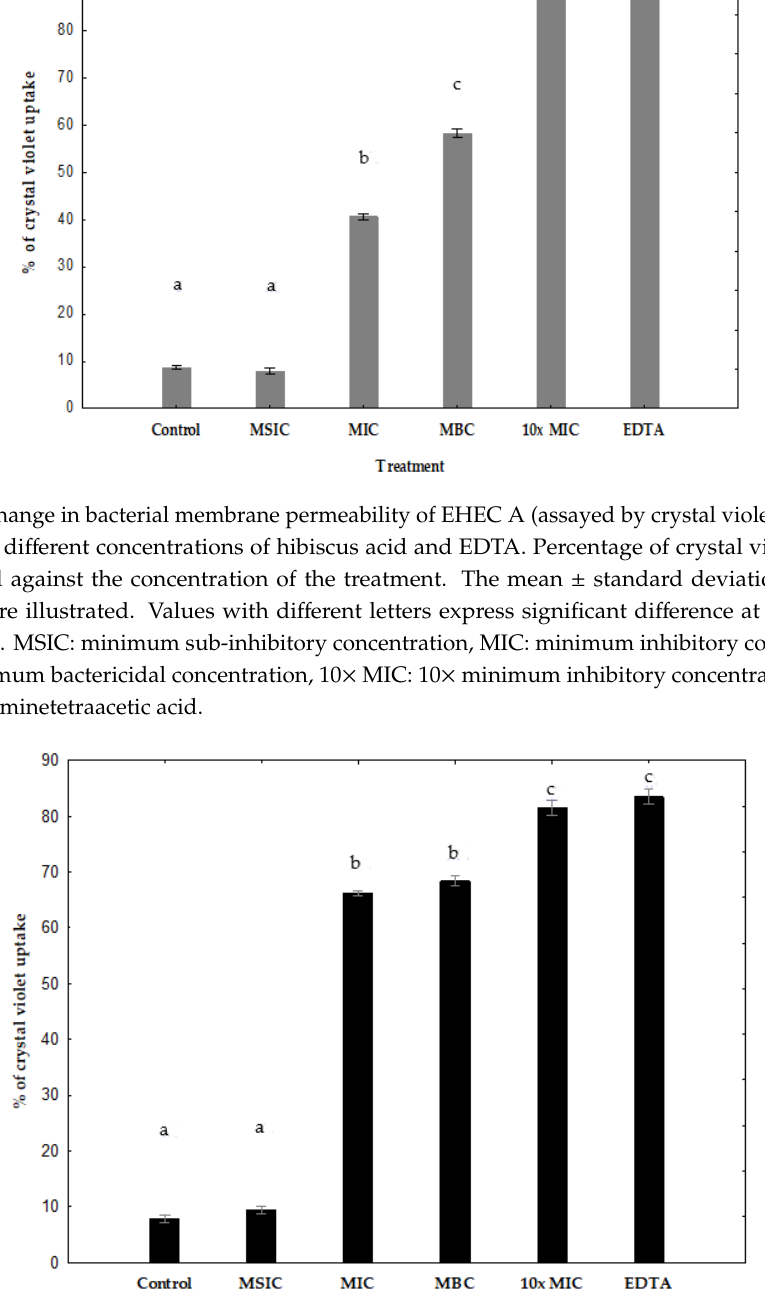
Figure 6. Change in bacterial membrane permeability of Salmonella C65 (assayed by crystal violet uptake) in presence of different concentrations of hibiscus acid and EDTA. Percentage of crystal violet uptake was plotted against the concentration of the treatment. The mean ± standard deviation for three replicates are illustrated. Values with different letters express significant difference at α = 0.05 by Tukey’s test. MSIC: minimum sub-inhibitory concentration, MIC: minimum inhibitory concentration, MBC: minimum bactericidal concentration, 10 × MIC: 10 × minimum inhibitory concentration, EDTA: ethylenediaminetetraacetic